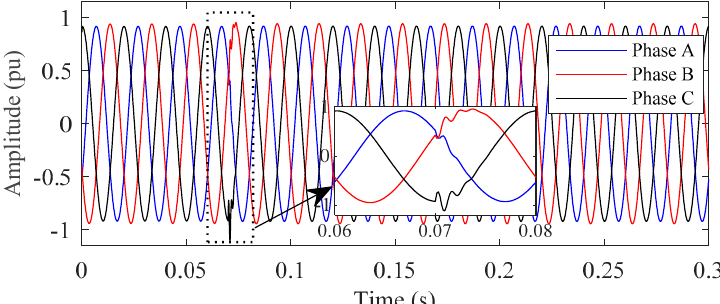
Figure 19. Related STA plots of PQ event at bus node 634 that the bank of the capacitor at bus node